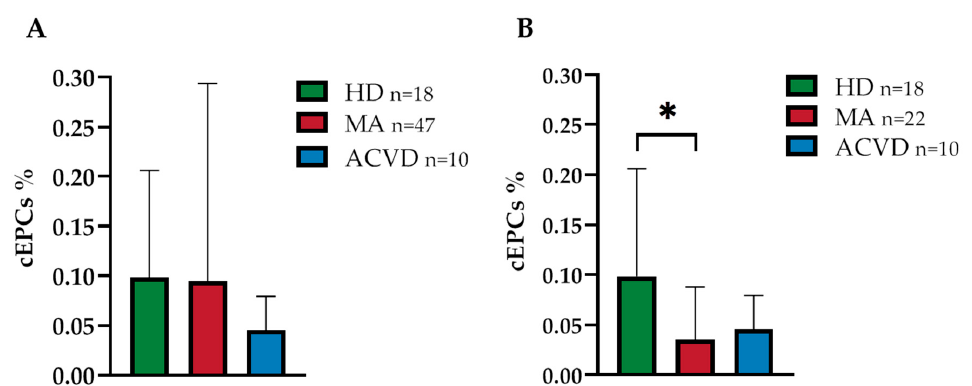
Figure 1. Endothelial progenitor cell (EPC) level in whole blood (WB) from ( A ) a heterogeneous and ( B ) a homogeneous (adult, Caucasian, non-operated) group of Moyamoya angiopathy (MA) patients, as compared with healthy donors (HD) and atherosclerotic cerebrovascular disease (ACVD) controls: Data are expressed as mean of circulating endothelial progenitor cell (cEPC)% ± standard deviation (SD), where cEPC% was calculated as follows: (cEPCs/µL/WB cells/µL) × 100; statistical significance (* p < 0.05) was calculated through Student’s t -test ( p = 0.032).